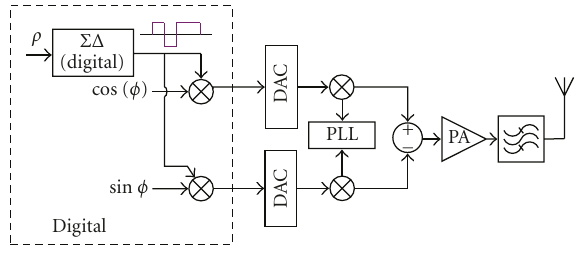
Figure 1: Architecture of a polar ΣΔ transmitter with baseband